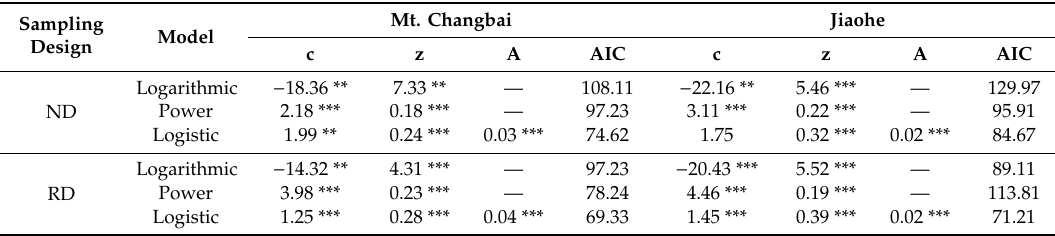
Table 3. The evaluation of the goodness-of-fit of the three species-area models using nested and random sampling